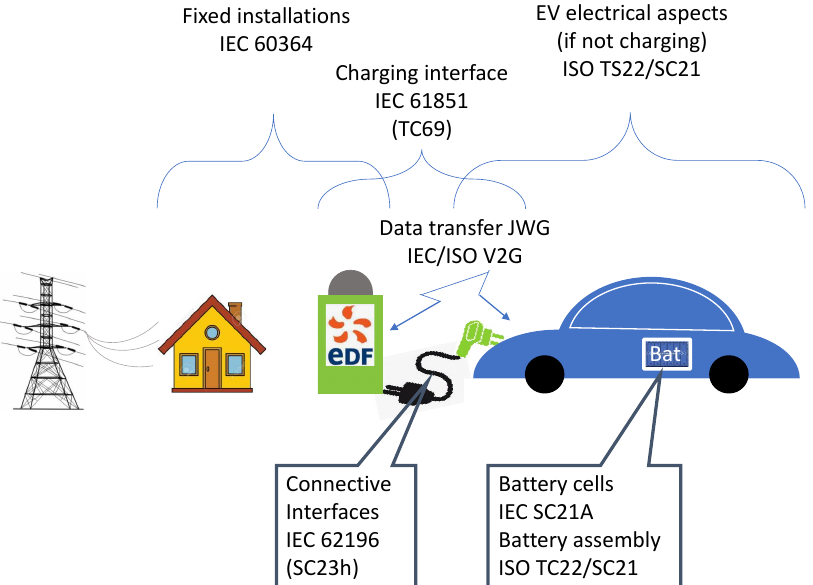
Figure 9. Diagram of the standards surrounding the connection of the EV to the electrical grid